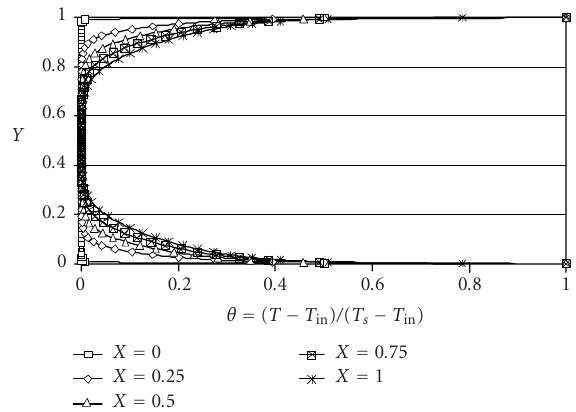
Figure 8: Nondimensional temperature distribution at di ff erent sections of the cooling channel for Re = 50000 and ˙ m r = 1 / 1.